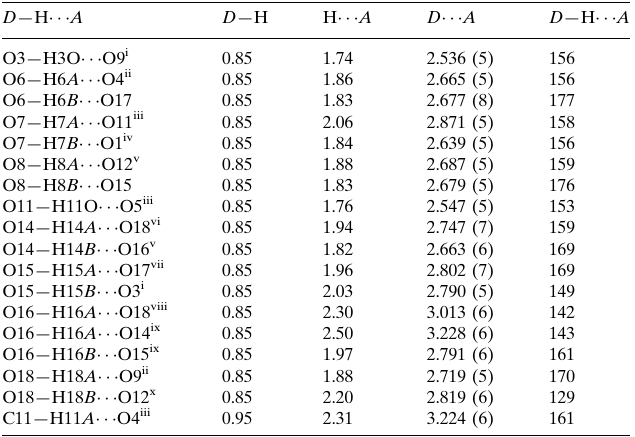
diffractometer Absorption correction: multi-scan ( SADABS ; Bruker, 2001)